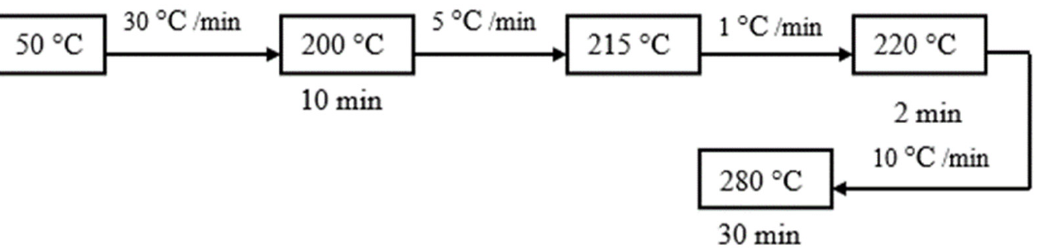
Figure 4. The oven temperature gradient for neutral